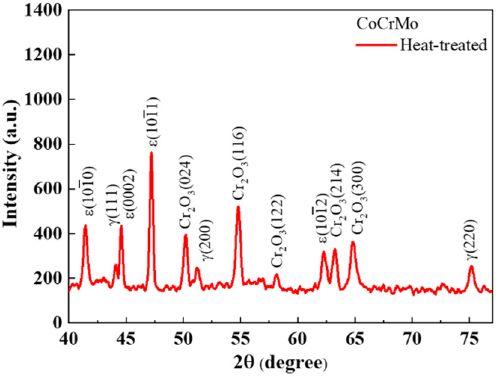
Figure 2. XRD profile on the surface of fully dense heat-treated CoCrMo alloy.